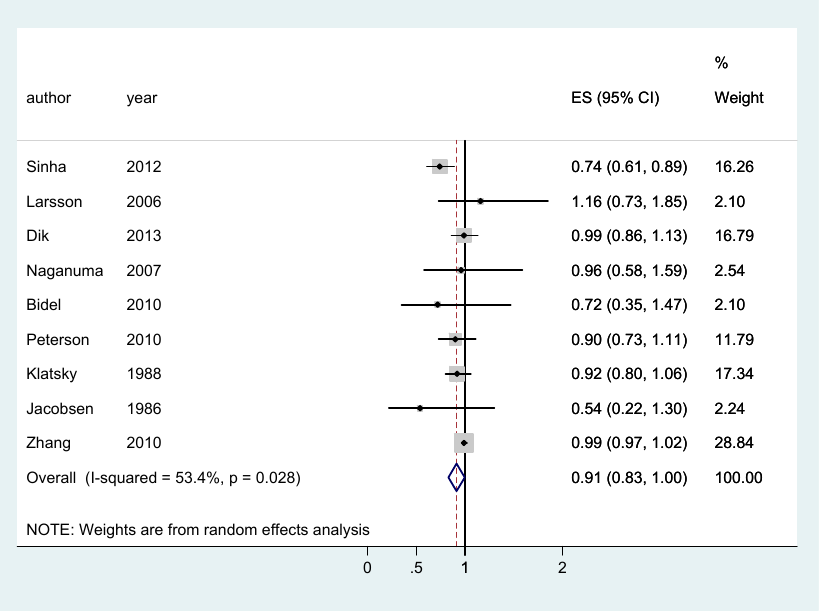
Figure 2. Forest plot of colon cancer in men and women combined.